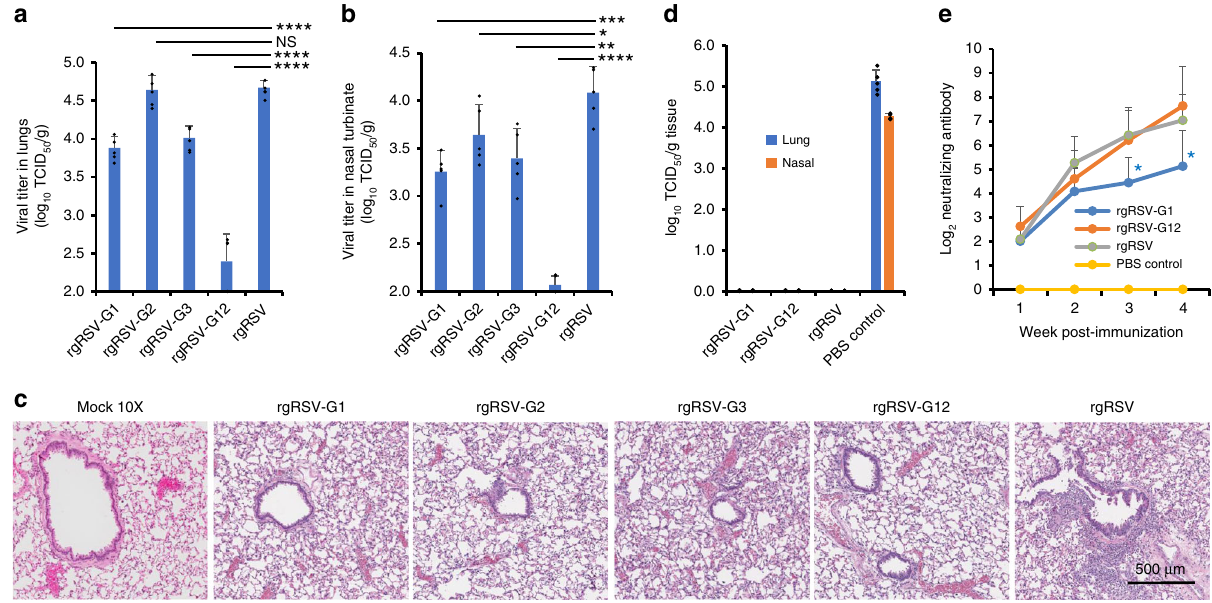
Fig. 9 Pathogenicity and immunogenicity of m 6 A-mutated rgRSVs in cotton rats. a RSV titer in lungs. Four-week-old SPF cotton rats were inoculated intranasally with 2.0 × 10 5 TCID 50 of each rgRSV. At day 4 post-infection, the cotton rats were killed, and lungs and nasal turbinates were collected for virus titration by TCID 50 assay. Viral titers are the geometric mean titer (GMT) of 5 animals± standard deviation. Detection limit is 2.0 log TCID 50 /g tissue. The P value (Student ’ s t -test) for rgRSV-G1, rgRSV-G3, and rgRSV-G12 is **** P = 9.99 × 10 − 6 , **** P = 4.06 × 10 − 5 , and **** P = 7.89 × 10 − 7 respectively. b RSV titer in nasal turbinates. The P value (Student ’ s t -test) for rgRSV-G1, rgRSV-G2, rgRSV-G3, and rgRSV-G12 is *** P = 0.000740, * P = 0.0460, ** P = 0.00623, and **** P = 2.88 × 10 − 7 respectively. c m 6 A mutated rgRSVs had less lung histopathological changes compared to rgRSV. Representative pathological changes from each group are shown. Right lung lobe of each cotton rat was fi xed in 4% neutral buffered formaldehyde, embedded in paraf fi n, sectioned at 5 µ m, and stained with hematoxylin-eosin (HE) for the examination of histological changes by light microscopy. Micrographs with ×20 magni fi cation (scale bar of 500 μ m) are shown. d m 6 A mutated rgRSV provides complete protection against RSV challenge. Four- week-old SPF cotton rats were inoculated intranasally with 2.0 × 10 5 TCID 50 of each rgRSV. At week 4 post-immunization, cotton rats were challenged with 2.0 × 10 5 TCID 50 rgRSV. At day 4 post-challenge, the cotton rats were killed, and lungs and nasal turbinates were collected for virus titration by TCID 50 assay. Viral titers are the geometric mean titer (GMT) of 5 animals± standard deviation. The detection limit is 2.0 log TCID 50 /g tissue. e rgRSV induced a high level of neutralizing antibody. Blood samples were collected from each rat weekly by retro-orbital bleeding. The RSV-neutralizing antibody titer was determined using a plaque reduction neutralization assay, as described in Materials and Methods. The P value (Student ’ s t -test) for rgRSV-G1 at week 3 and 4 is * P = 0.0166 and * P = 0.0490,